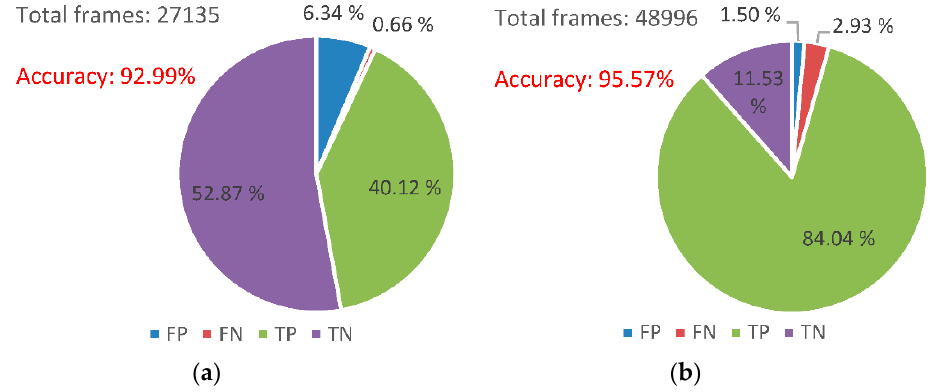
Figure 15. Results on benchmark 1 over: ( a ) day, ( b ) night.